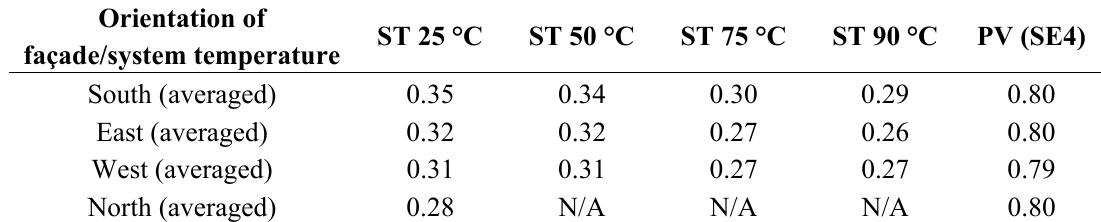
Table 4. Effective revenue